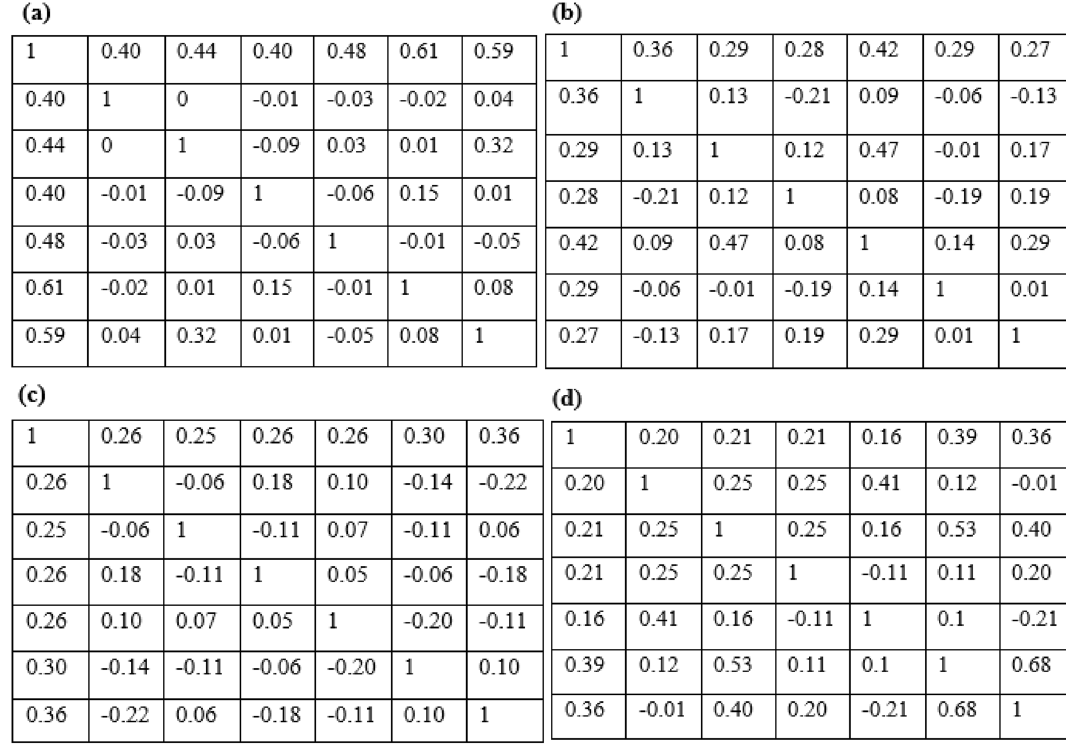
Table 3. The correlation matrix of v-transformed copula for four lithotypes: (a) granite; (b) quartz; (c) basic; (d)